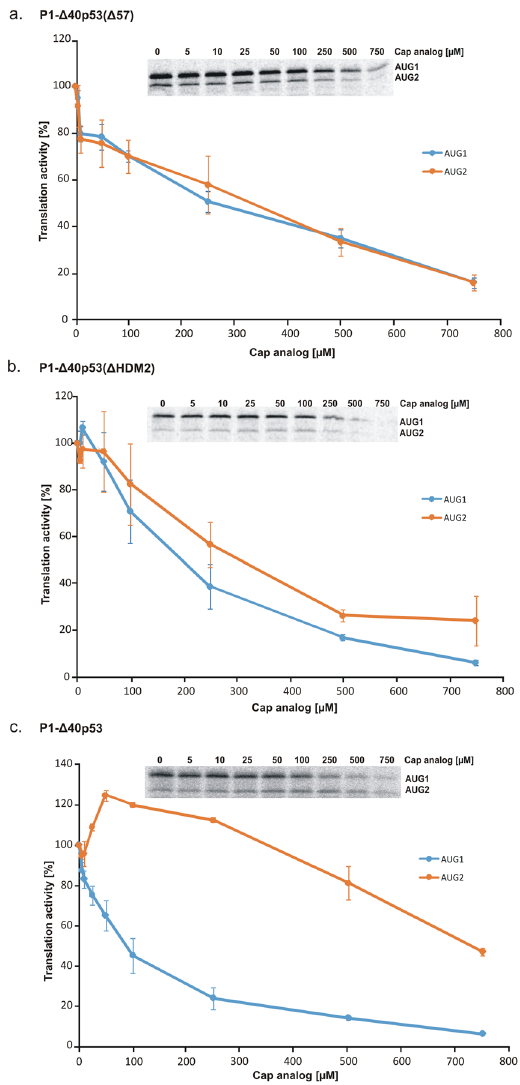
Figure 6. Translational inhibition of mRNA constructs with the cap analogue in RRL. The capped ( a ) P1- Δ 40p53( Δ 57), ( b ) P1- Δ 40p53( Δ HDM2) and ( c ) P1- Δ 40p53 mRNAs were translated in RRL in the presence of an increasing concentration of the cap analogue (m7GpppG) to inhibit cap-dependent translation. The amounts of protein products resulting from AUG1 and AUG2 initiation codons were determined, and following quantification and normalization to the values with no cap analogue added, they were displayed on the graph. The graph presents the mean of three independent measurements, with the standard deviations calculated and displayed on the diagrams. The full-length images of the gels were included in Suppl. Fig.